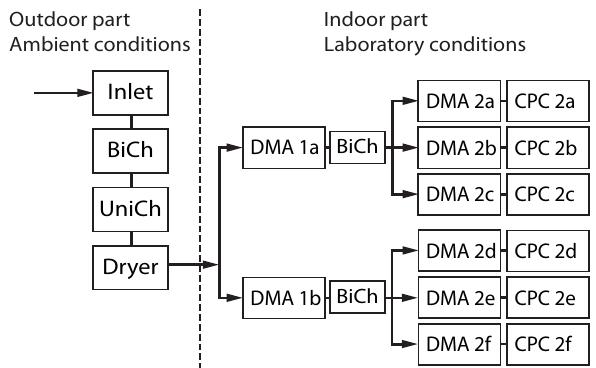
Fig. 1. The principle of the DAA. Droplets and particles are pro- cessed in several steps by aerosol charging mechanisms in bipo- lar (BiCh) and unipolar chargers (UniCh), diffusion drying (Dryer), electrostatic aerosol spectrometry (DMA), and counting in conden- sation particle counters (CPC) in order to obtain the desired rela-